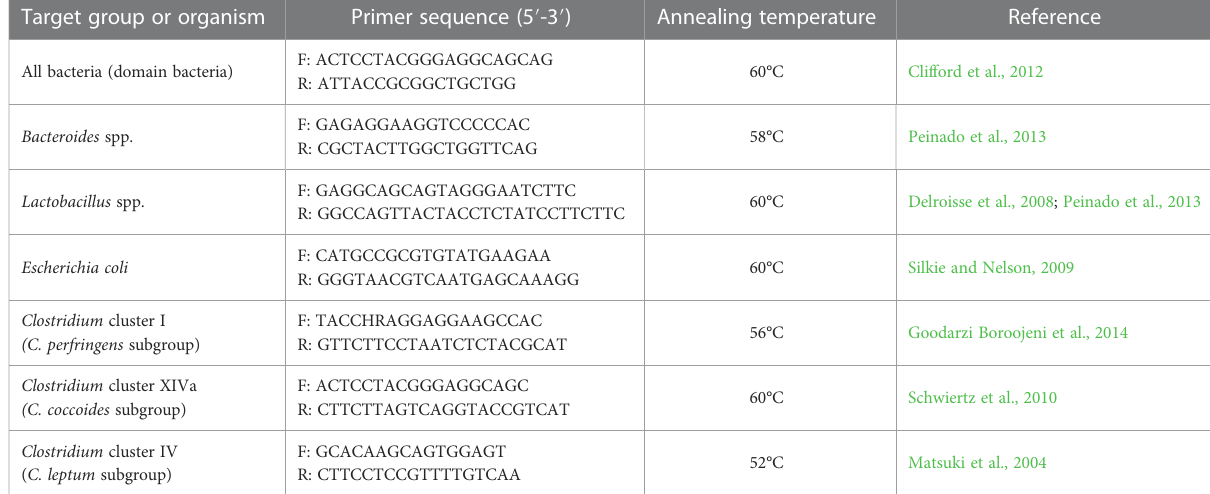
TABLE 1 Primers targeting 16S rRNA gene used for determination of luminal- and mucosa-associated microbiota composition by real-time